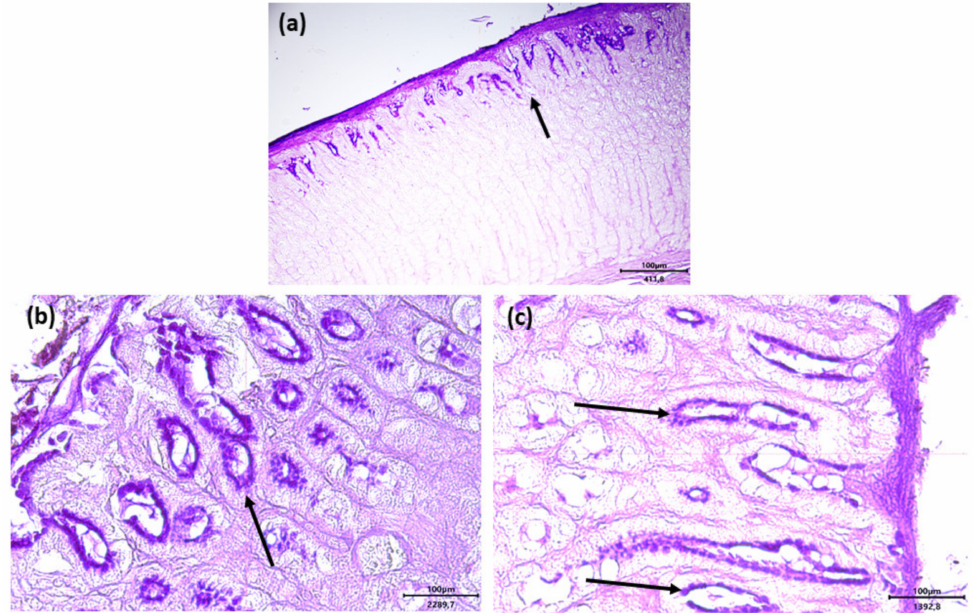
Figure 8. Fundic mucosa of the stomach, AB/PAS staining. ( a ), ( b ), and ( c ) samples indicate control, and groups supplemented with flaxseed and fish oil, respectively. Several mucous cells are detected containing mainly acidic (blue-stained, arrows) glycoconjugates. Proper scale bar is located in each figure. For the interpretation of the arrow and the asterisk see the